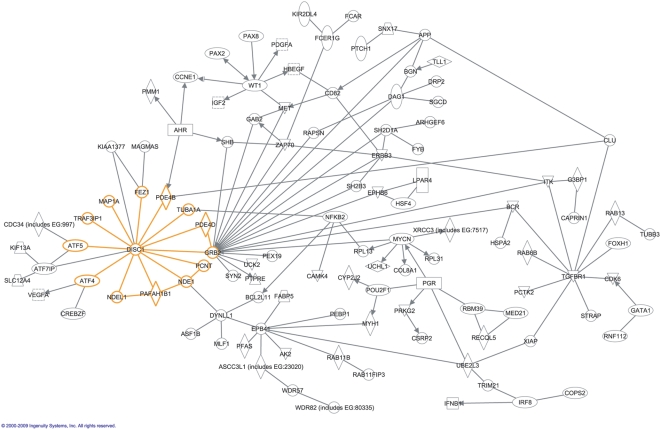
Network of how 100 of the 528 genes identified with significant differential expression relate to DISC1and its core interactors.Network generated through the use of Ingenuity Pathway Analysis (Ingenuity Systems®, www.ingenuity.com), using the build function and connecting the identified genes to the core DISC1 interactome, only allowing for direct interaction. Relationships are supported by at least 1 reference from the literature, from a textbook, or from canonical information stored in the Ingenuity knowledge base.